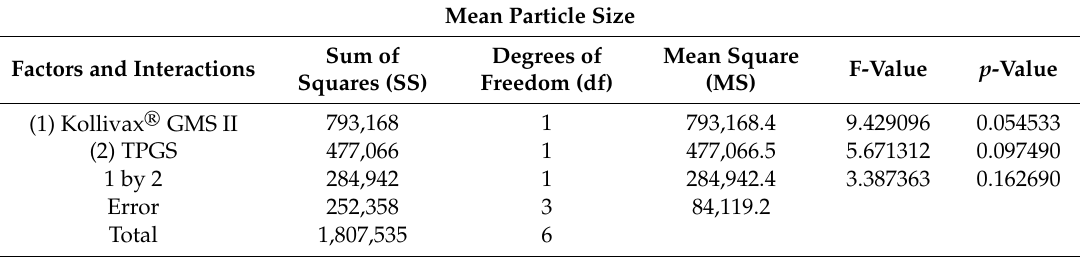
Table 8. Analysis of the mean particle size by ANOVA statistical test. Determination coe ffi cient (R 2 ) =